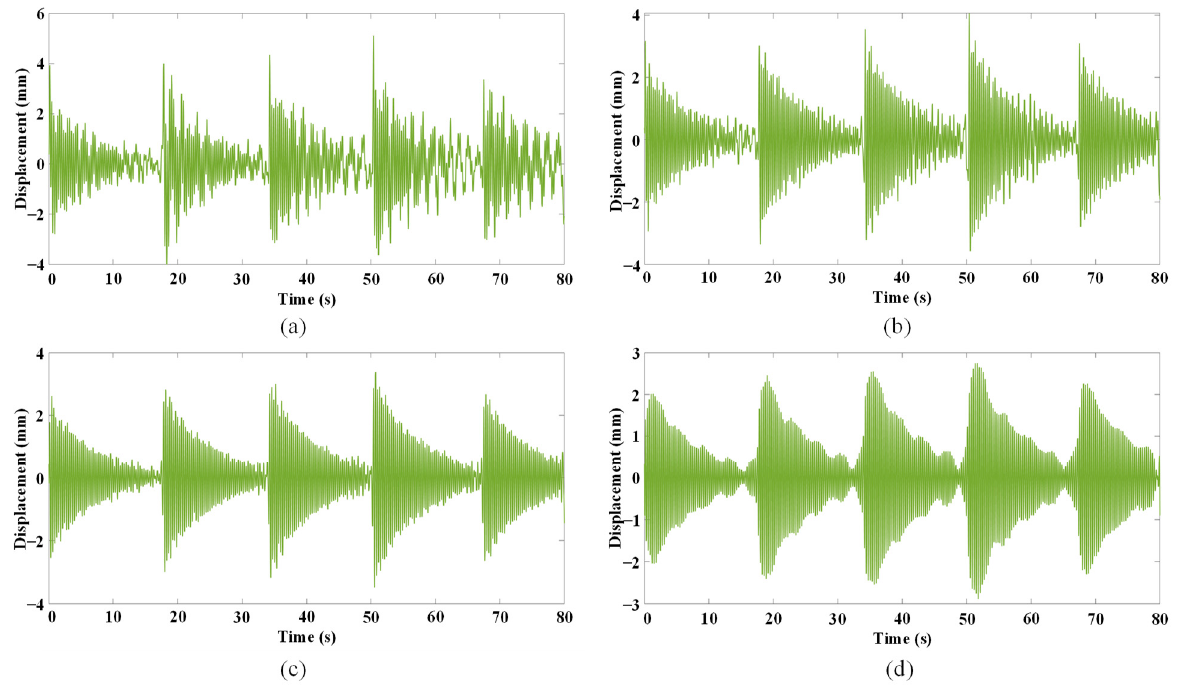
Figure 9. Corrected signals of 4 cases: ( a ) F = 0.5 Hz; ( b ) F = 1 Hz; ( c ) F = 2 Hz; ( d ) F = 3 Hz.